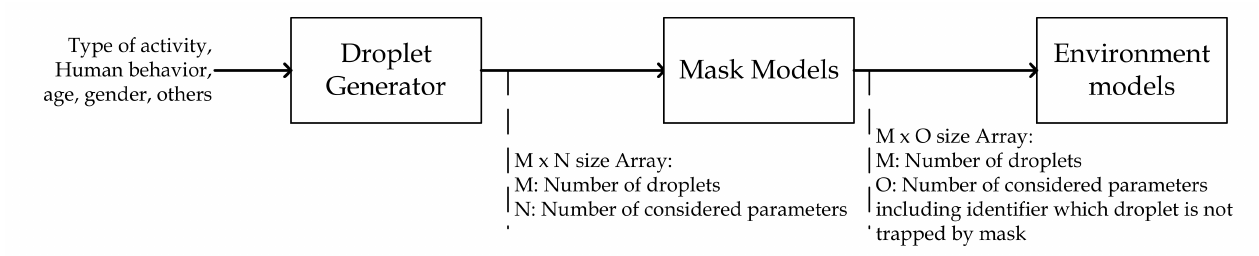
Figure 1. The Proposed Systematic Approach to predict Droplet